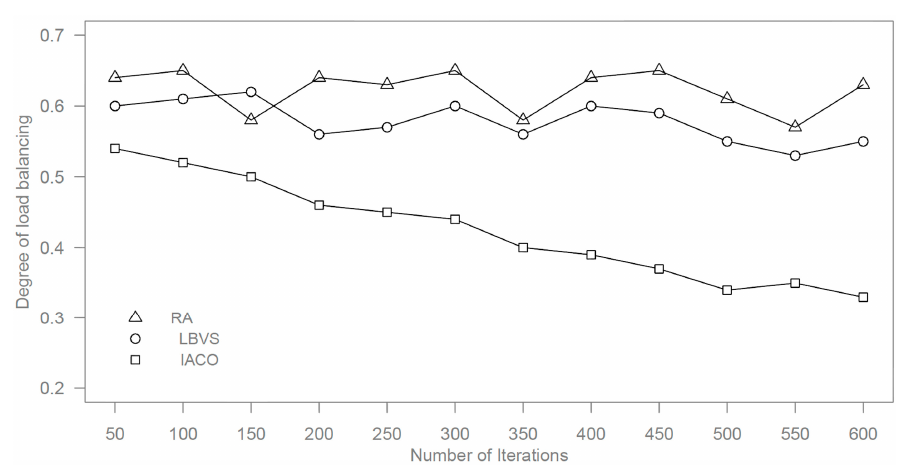
Figure 6. Execution time by different algorithms.